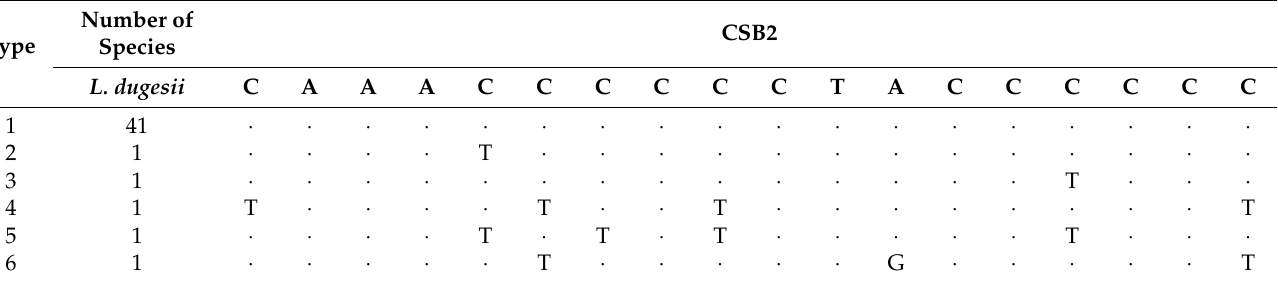
Table 5. Type of conserved structure element of CSB2 in Lacertidae.